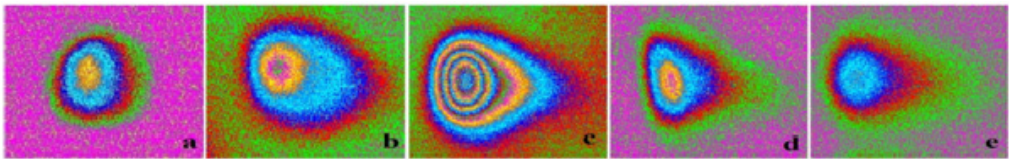
Figure 2. Representative comet images: showing undamaged DNA from control ( a ) with increasing degree of DNA damage as a result of Dimethoate exposure—low ( b ), medium ( c ), high ( d ) and extensively high damage ( e ) exhibiting increasing degree of DNA fragmentation.